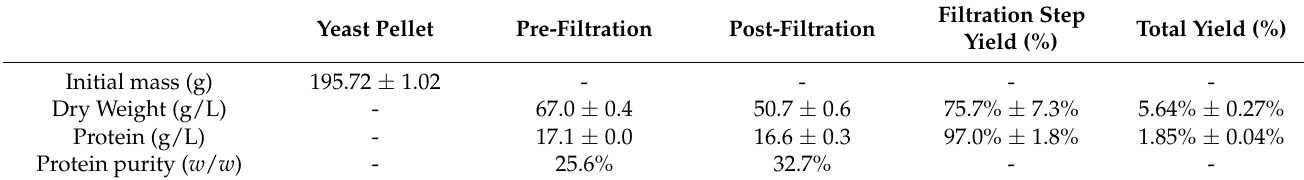
Yeast Pellet Pre-Filtration Post-Filtration